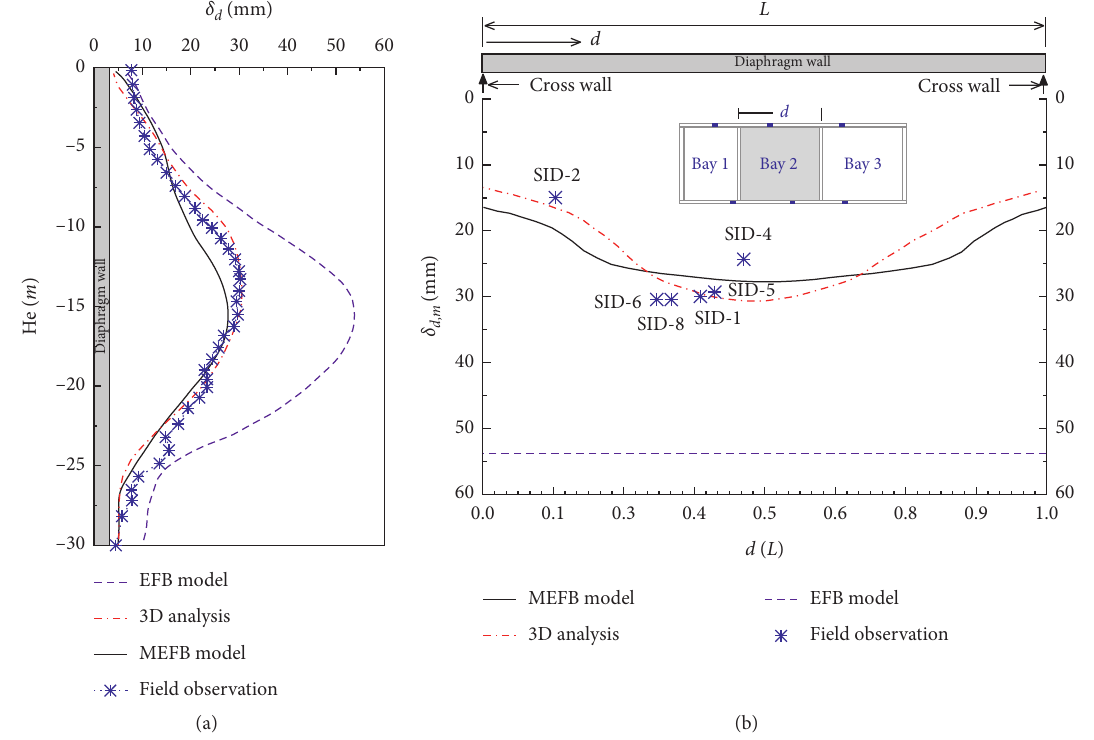
Figure 9: Comparison of the computed maximum lateral wall deflections at various sections and those from field observation for case 1. (a) Wall deformation at SID-1. (b) Wall deformations at GL-15.0 m in various cross-sections (d/L).